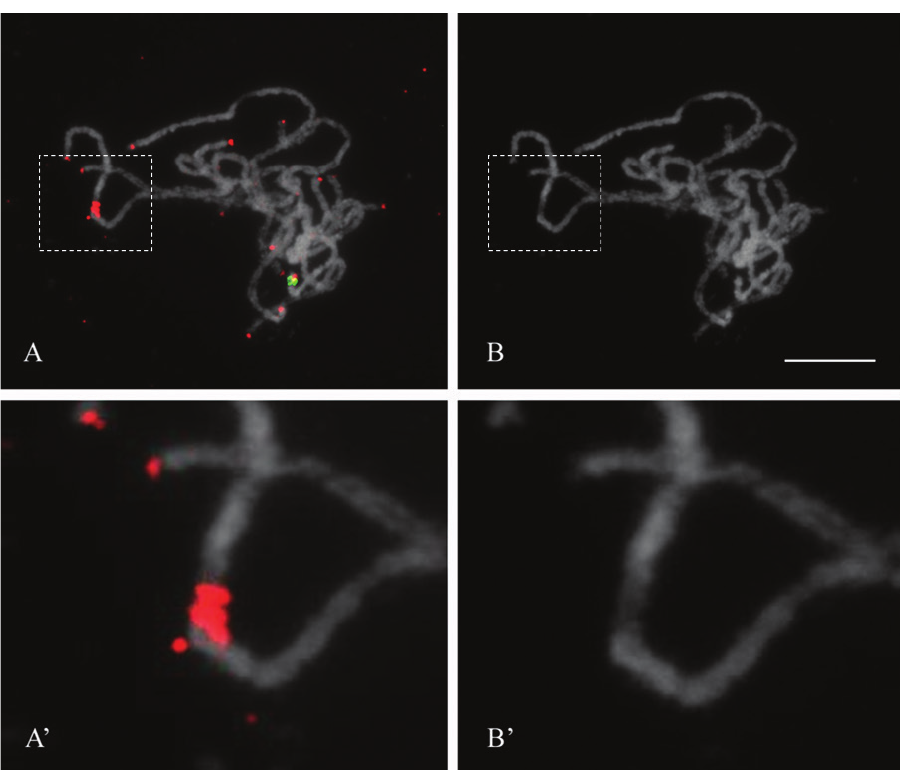
Figure 4. High resolution physical mapping of ITR on R. wichurana pachytene chromosomes. FISH with the Arabidopsis -type telomere repeat probe (red) and 45S (green). Merged ( A ) and the DAPI gray scale ( B ) pictures are shown. FISH was performed under the low hybridization stringency condition. Dotted lines show the regions that were digitally enlarged (A’ and B’). Scales bar: 5